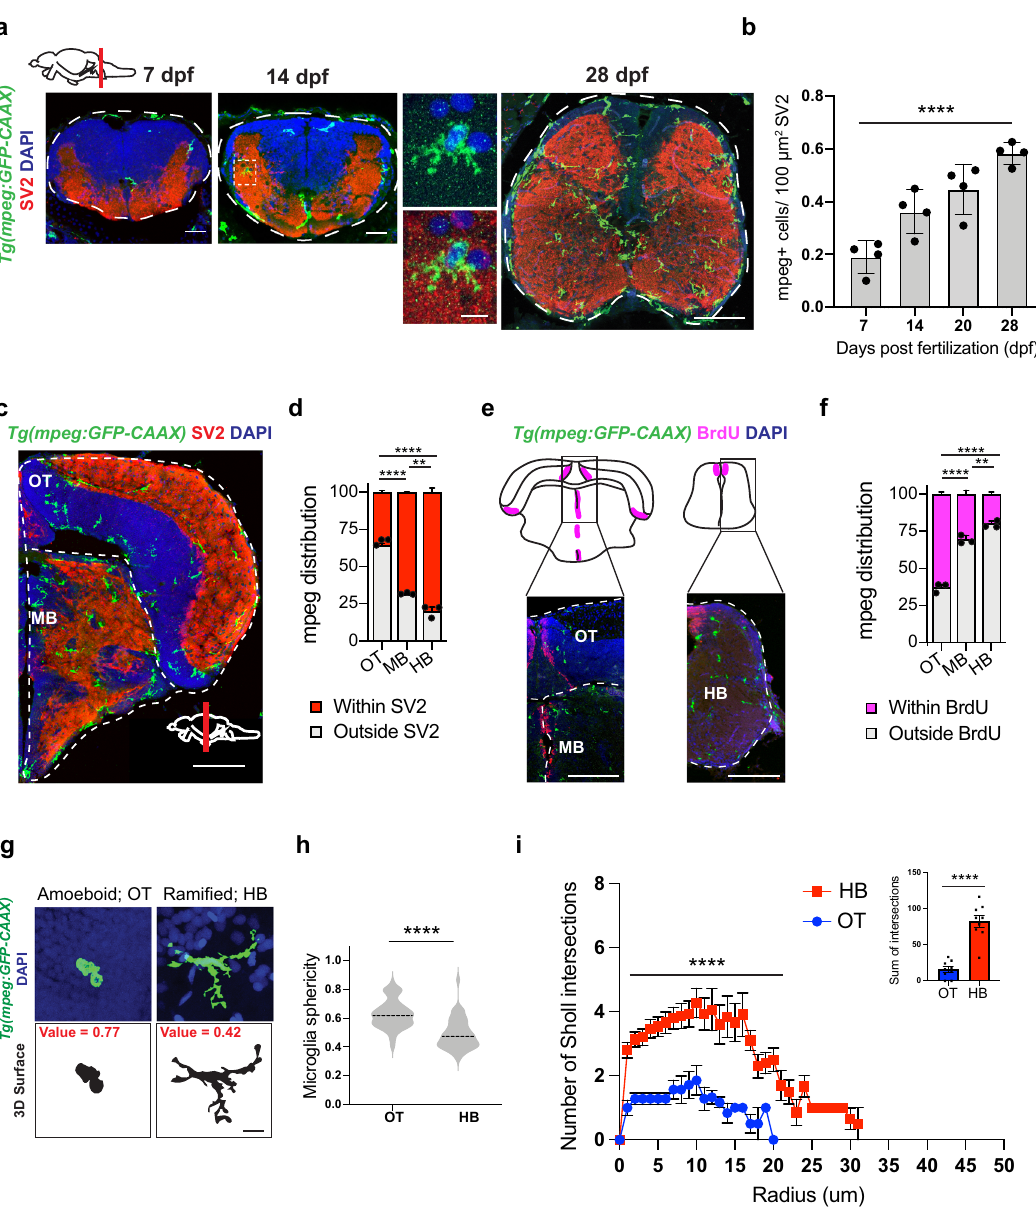
Fig. 1 Phenotypically distinct populations of microglia in synaptic and neurogenic regions of zebra fi sh brain. a Representative images of microglia ( mpeg1.1-GFP + ) and synapses (SV2 antibody stain) in developing zebra fi sh hindbrain. Inset: representative synapse-embedded microglia at 14 dpf. Scales: 7 – 14 dpf, 20 µ m; 28 dpf, 50 µ m; inset, 5 µ m. All images are representative of the n = 4 replicates. b Quanti fi cation of mpeg1.1-GFP + cells per 100 μ m 2 of SV2 + synaptic area at 7, 14, and 28 days post fertilization. Dots represent four individual fi sh, data are mean±SD. One-way ANOVA * p <0.0001. c – d Representative images and quanti fi cation of the proportion of mpeg1.1-GFP + cells in synaptic (SV2 + ; red) vs. cellular (DAPI + /SV2 − ; gray) areas. Distribution quanti fi ed within each brain region as outlined (dotted lines): midbrain (MB), optic tectum (OT), and hindbrain (HB, see panel 1A). Mean ±SEM from n = 3 fi sh. Two-way ANOVA with Tukey ’ s post hoc comparison; **** p <0.0001, ** p <0.0029. Scale: 50 µ m. e – f Representative images and quanti fi cation of the proportion of mpeg1.1-GFP + cells within 20 µ m of BrdU + neurogenic regions (purple) vs. outside neurogenic regions (gray). Mean ±SEM from n = 3 fi sh. Two-way ANOVA with Tukey ’ s post hoc comparison; **** p <0.0001, ** p <0.0062. Scale: 50 µ m. g Representative images of mpeg1.1-GFP + microglia and thresholded maximal projections in OT and HB at 28 dpf. Value = sphericity; scale 0 – 1, 1 = most spherical/ameboid. 5 µ m. Images are representative of respective values indicated in red. h Quanti fi cation of microglial sphericity from images thresholded as in g . n = 50 microglia per region from n = 4 fi sh. The dotted line indicates the median. two-tailed unpaired t test; **** p <0.0001 I Sholl analysis quantifying the number of intersections ( y axis) measured at 1 µ m increments from the soma ( x axis) in microglia from optic tectum (OT) and hindbrain (HB). Total of n = 9 microglia per region from n = 3 fi sh. Mean ±SEM. Two-way ANOVA with Sidak ’ s multiple comparisons; **** p <0.0001. Inset: two-tailed unpaired t test; **** p <0.0001. See also Fig. To focus on myeloid cells, which are the dominant immune cell innate lymphocyte-like cells (il13, gata3) 34 – 37 ; Fig. S2c). Thus, subset, we reclustered 3539 mpeg1.1 + cells. After quality control multiple immune cell subsets, predominately myeloid in origin, are present in the zebra fi sh brain, although it is possible that some and fi ltering, the myeloid subset yielded six distinct clusters of these may be circulating rather than tissue-resident. (Fig. 2c; Fig. S2d – g; Supplementary Data S2) at a clustering